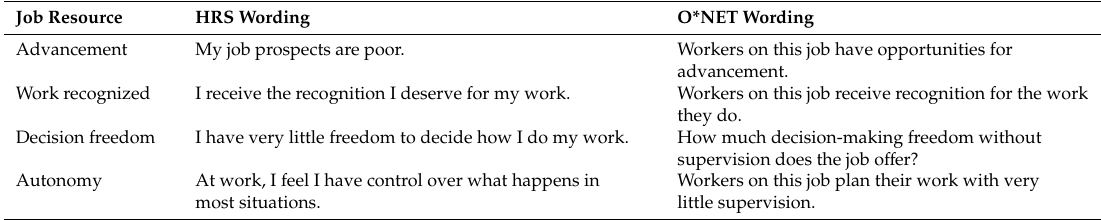
Table 1. Description of HRS and O*NET job